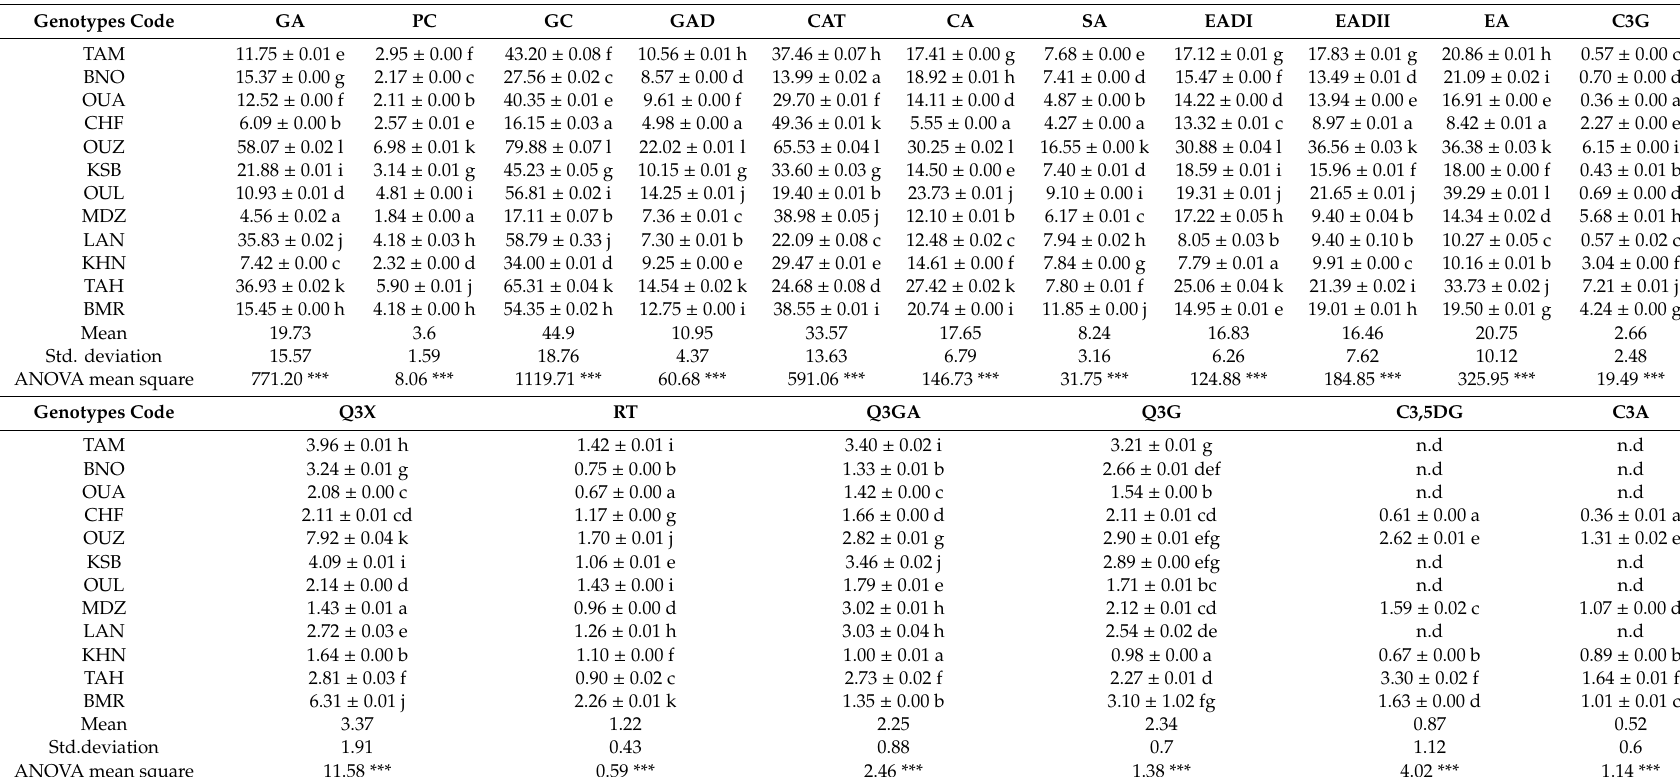
Table 4. Polyphenolic compounds of twelve strawberry genotypes (mean ± SD in mg GAE / 100 g